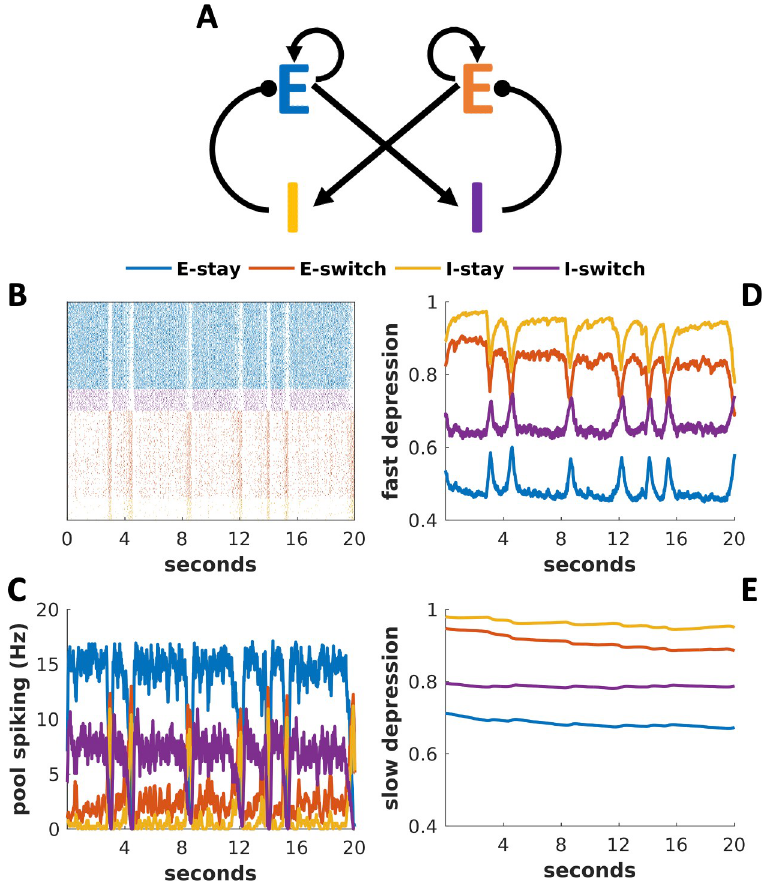
Fig 1. Network in a default mode without stimulus possesses two quasi-stable attractor states. Example data from a fast (“entice to stay”) network in the absence of stimulus. (A) Circuit diagram, indicating cross-inhibition between excitatory populations of cells labeled E, inhibited by their corresponding inhibitory population labeled I. (B) Spike rasters from model neurons arranged in rows grouped by their corresponding populations and color-coded as in (A). Each dot represents one spike from the model neuron. (C) Mean firing rate of each population as a function of time. (D) Dynamics of the fast-depression variable. (E) Dynamics of the slow-depression variable. (C-E) Line color indicates which population’s average variable is plotted with the color code as in